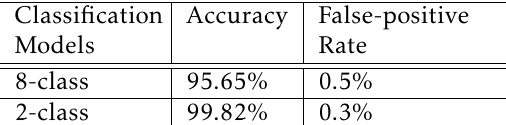
Figure 5. Confusion matrix for 8-class classification in the SAE model